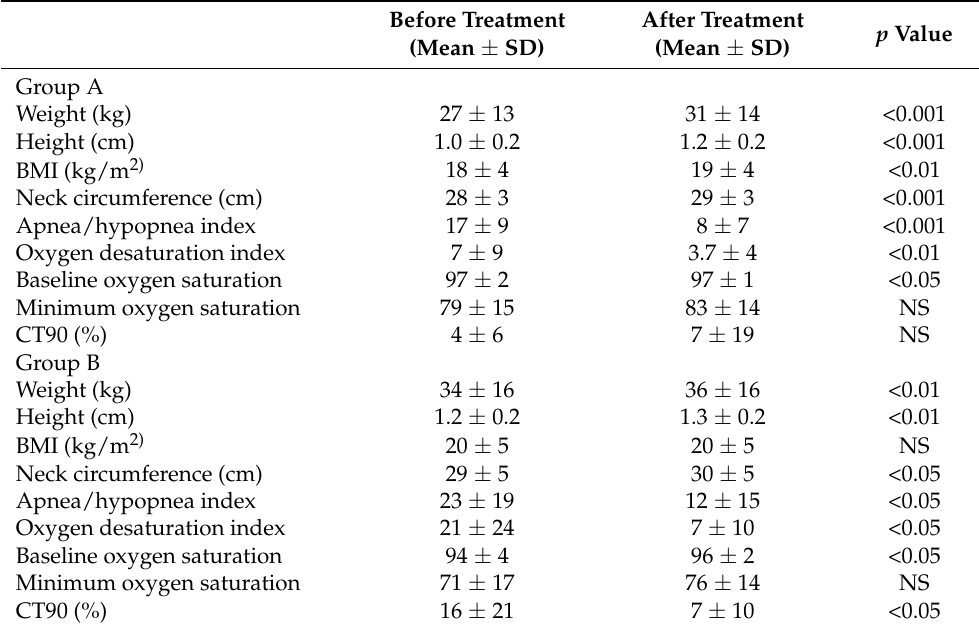
Table 3. Comparison of anthropometric measurements and nocturnal PSG values in Groups A and B before and after